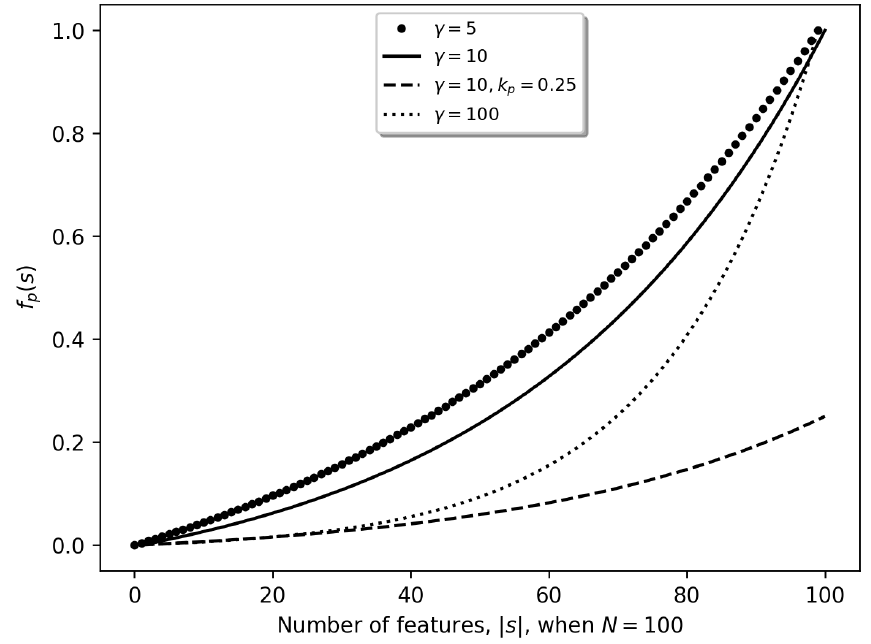
Figure 2. Penalty function.